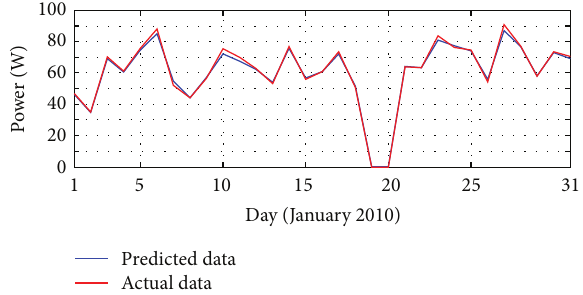
Figure 12: Results of real data and GRNN for January 2010.